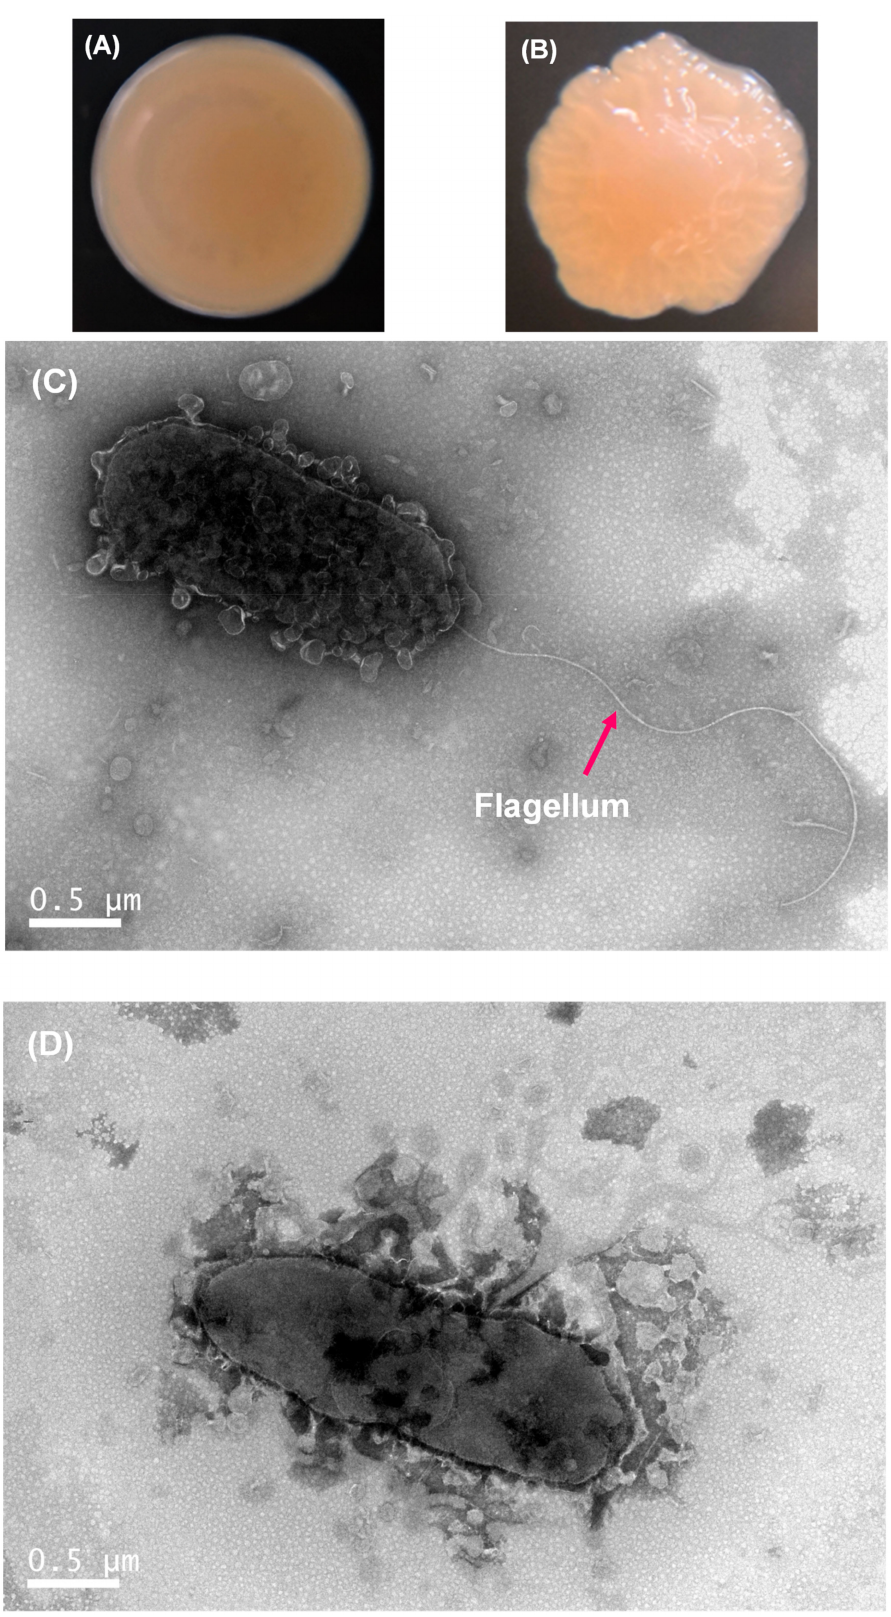
Figure 3. Colony morphology of wild-type ( A ) and ∆ fliP ( B ) strains and transmission electron microscopy images of wild-type ( C ) and ∆ fliP ( D )